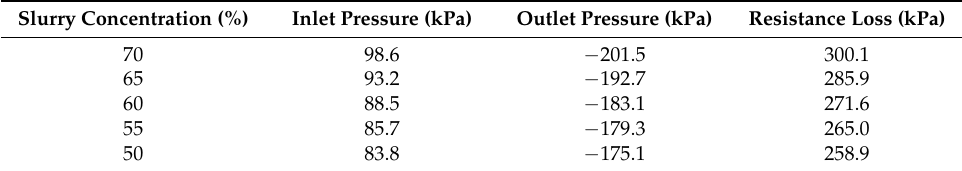
Table 1. Resistance loss of different slurry concentrations.